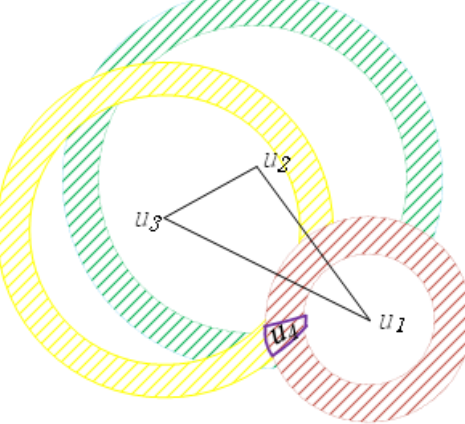
Figure 2. Using Euclidean distance to describe